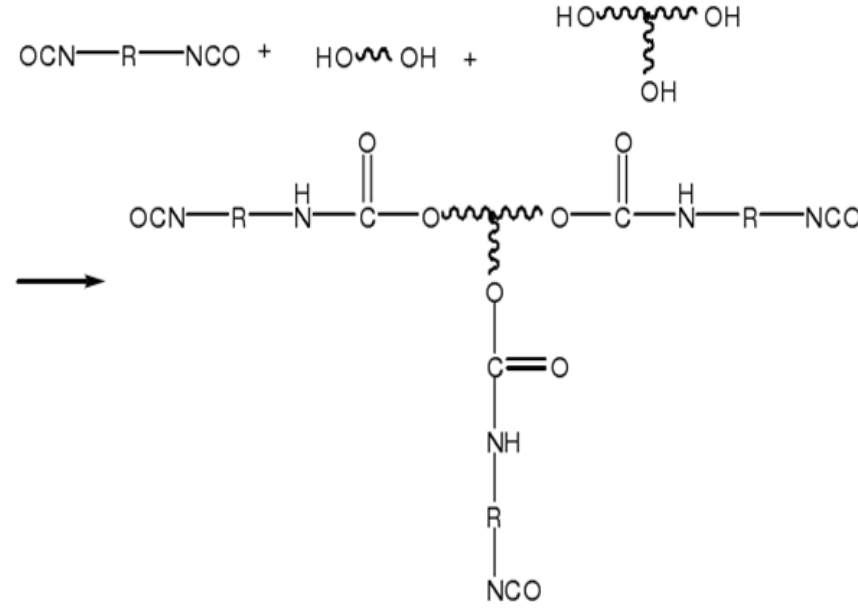
Figure 1. The chemical reaction equation of synthesis process.